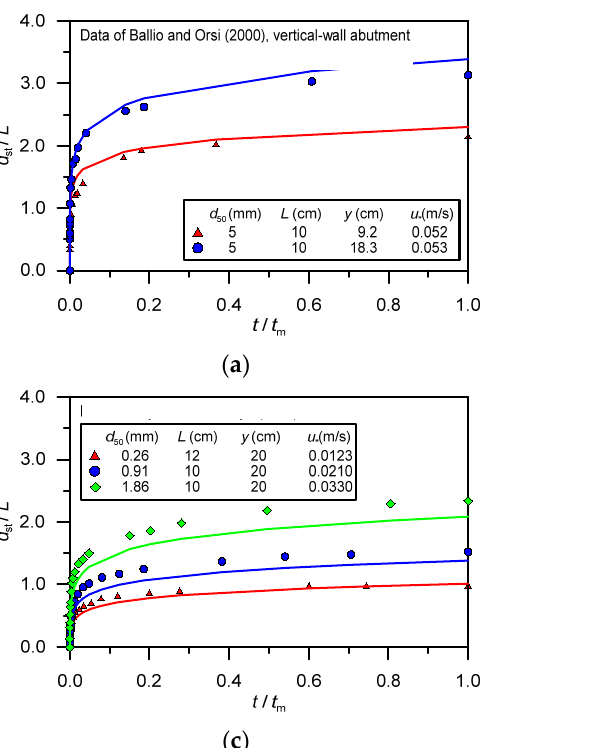
Figure 10. Comparison of computed and measured abutment-scour evolution under Type-II step- wise (symmetrical) hydrograph. ( a ) Rectangular abutment ( b ) Semicircular abutment ( c ) Trapezoi- dal abutment. Figure 11. Comparison of computed and measured abutment-scour evolution under Type-III step- wise (delayed) hydrograph. ( a ) Rectangular abutment ( b ) Semicircular abutment ( c ) Trapezoidal abutment.